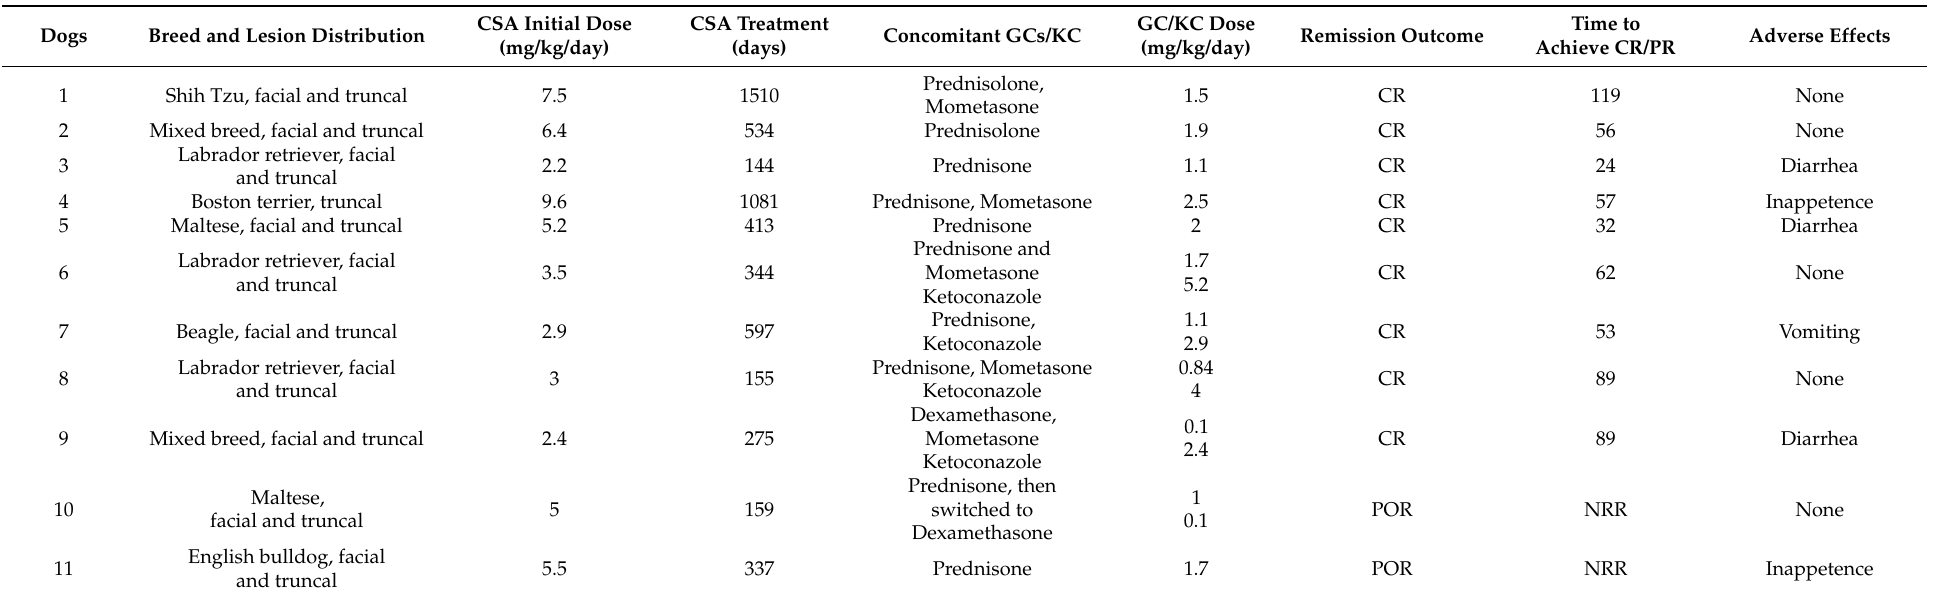
Table 1. Dogs treated with oral modified ciclosporin (CSA): dosage, duration, concomitant glucocorticoid (GC) and ketoconazole (KC) doses, clinical outcome, and reported adverse effect. GC, glucocorticoids; KC, ketoconazole; Mometasone furoate 0.1% topical, Mometasone; CR, complete remission; POR, poor response; NRR, not reached